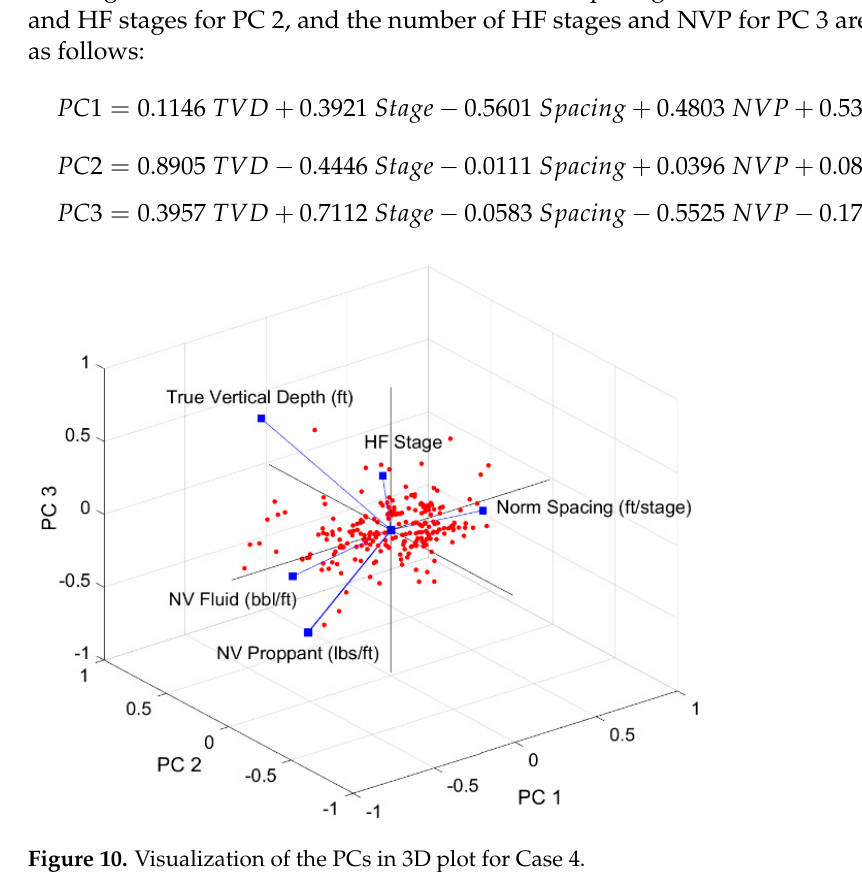
Figure 10. Visualization of the PCs in 3D plot for Case